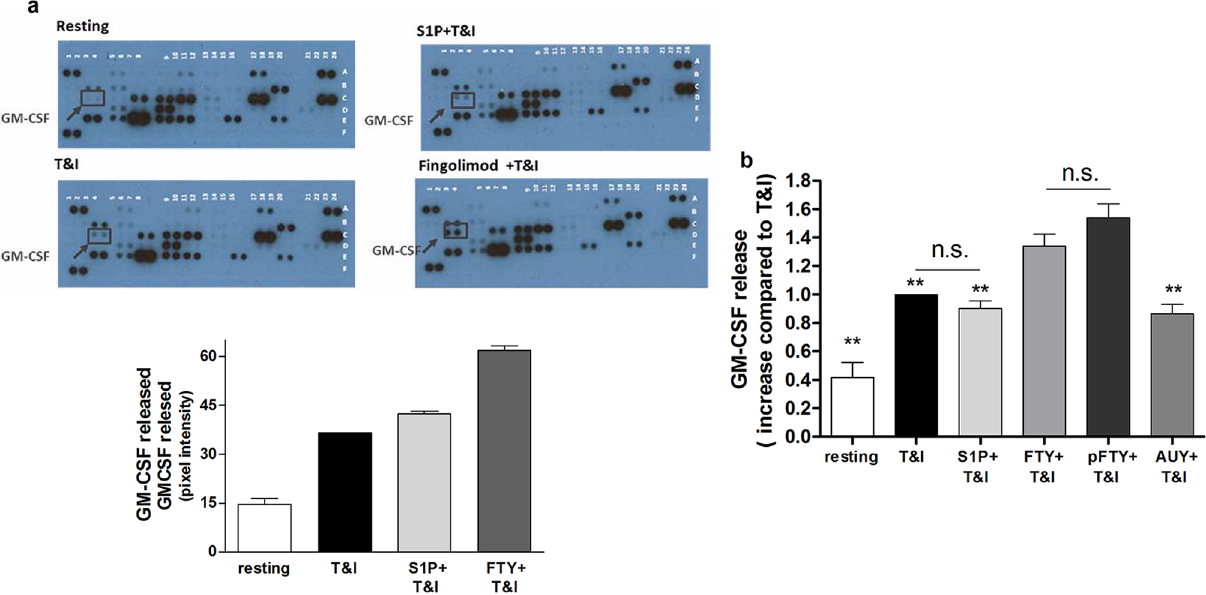
Fig 4. hAST release GM-CSF after S1P modulation. a . hAST are exposed to T&I (10 U/ml, 5 U/ml) either alone or in combination with S1P (50 nM) or FTY (50 nM) for 6 h then washed and kept in fresh media for 18 h. The supernatant, was collected and released factors were analyzed by a cytokine/growth factor array (R&D Systems). The upper panel shows blots to identify factors present in the ACM after stimulation as indicated; the lower panel shows quantification of the released GM-CSF (pixel intensity). b . ELISA evaluation of the released GM-CSF after T&I exposure either alone or in the presence of S1P (50 nM),